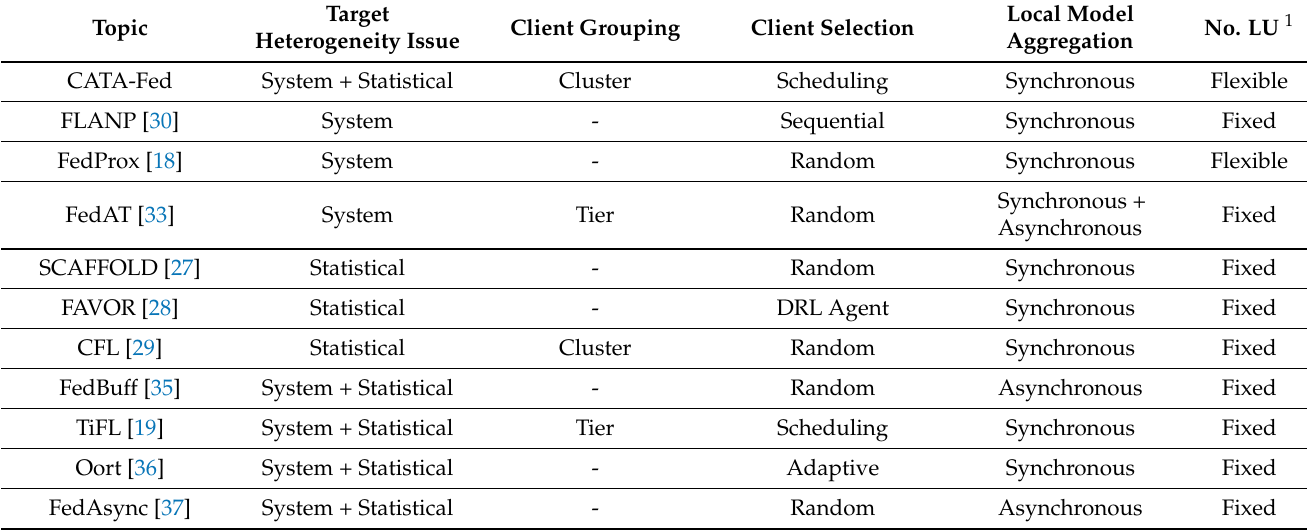
Table 1. Features of FL